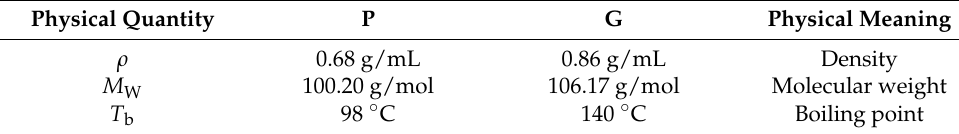
Table 2. Basic physical quantities of n-heptane (P) and xylene (G) at room